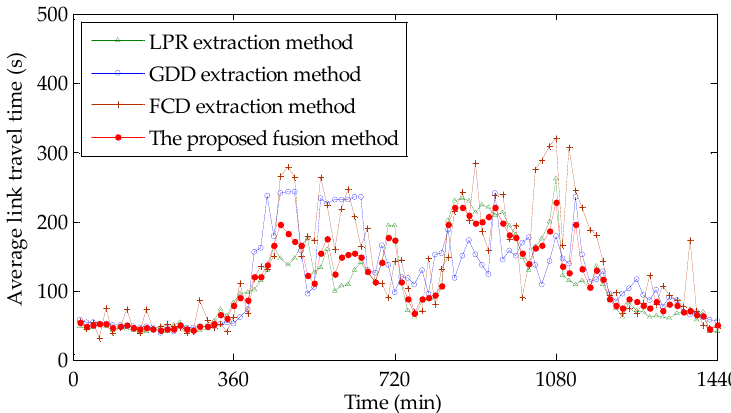
Figure 7. Average link travel time curves based on multi-sensor traffic data.